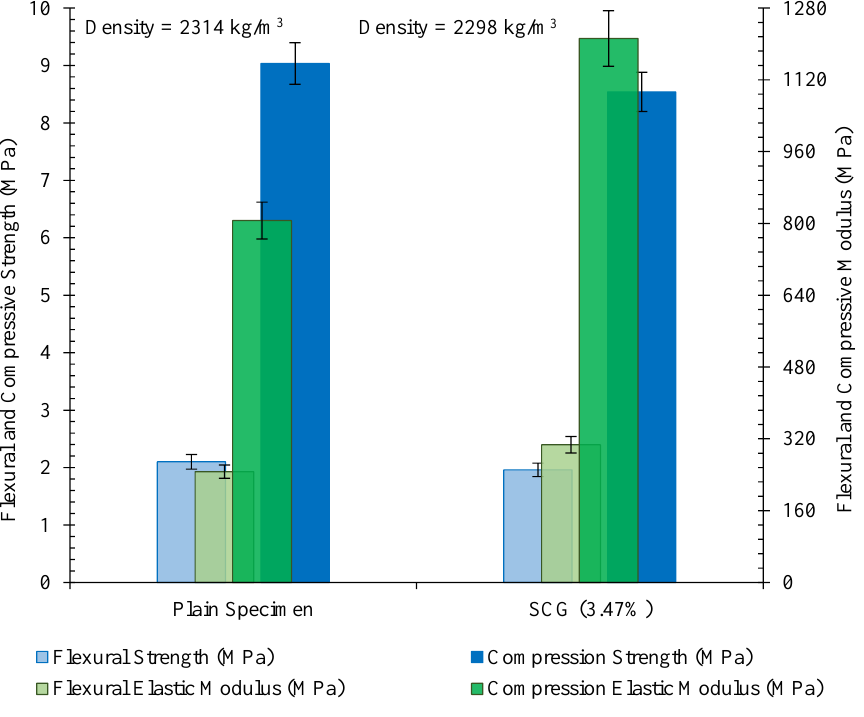
Figure 18. Mechanical properties of the 10 × 10 × 85 cm 3 beam reinforced with 3.47% of CNT/GNP (SCG 3.47%).